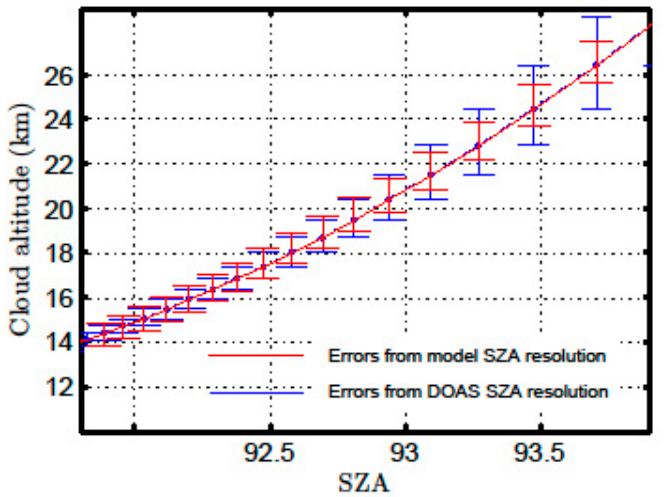
Figure 7. Comparison between the errors in cloud altitude of the Monte-Carlo radiative transfer model (RTM) (red) and the spectrometer (blue). In both cases the errors were computed from the SZA resolution at the maximum of CI.